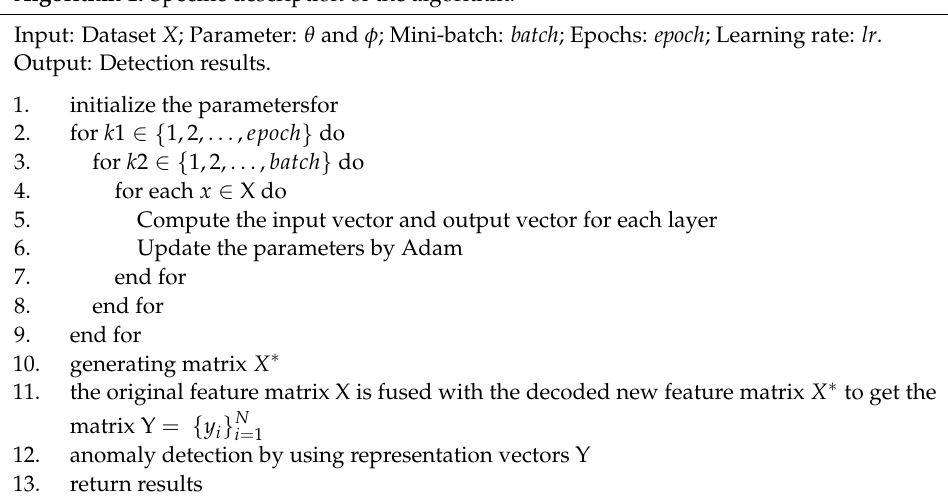
Algorithm 1. Specific description of the